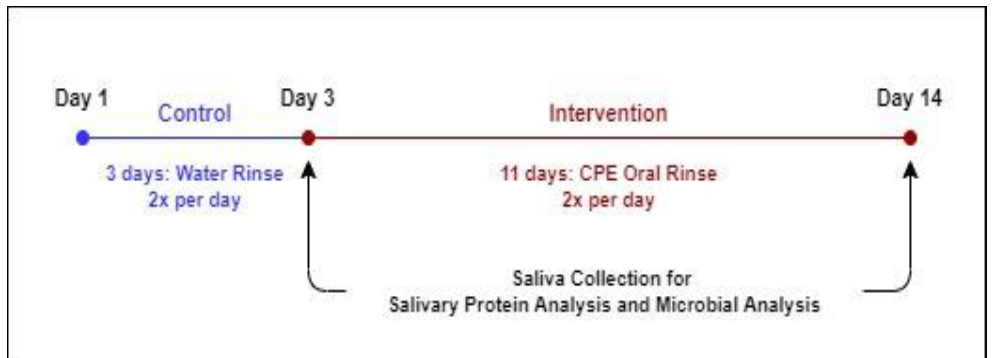
Figure 1. Experimental Timeline.